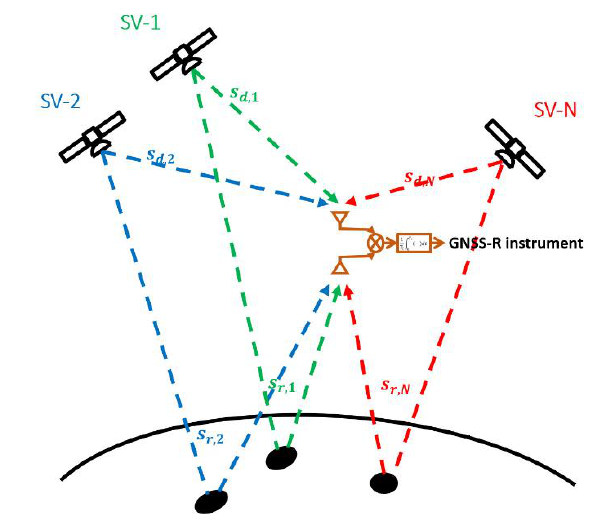
Figure 1. GNSS-R instrument multi-static configuration receiving the reflected signals from different space vehicles